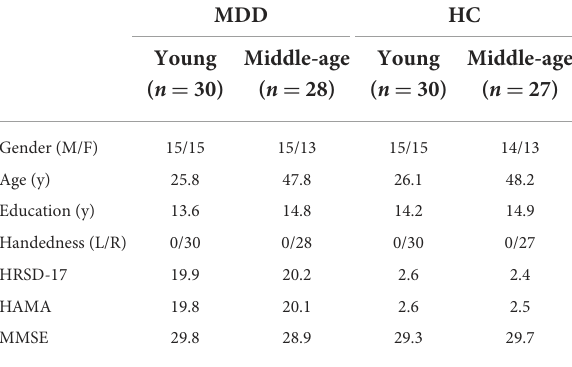
TABLE 1 Demographic and clinical characteristics of major depressive disorder (MDD) and healthy controls